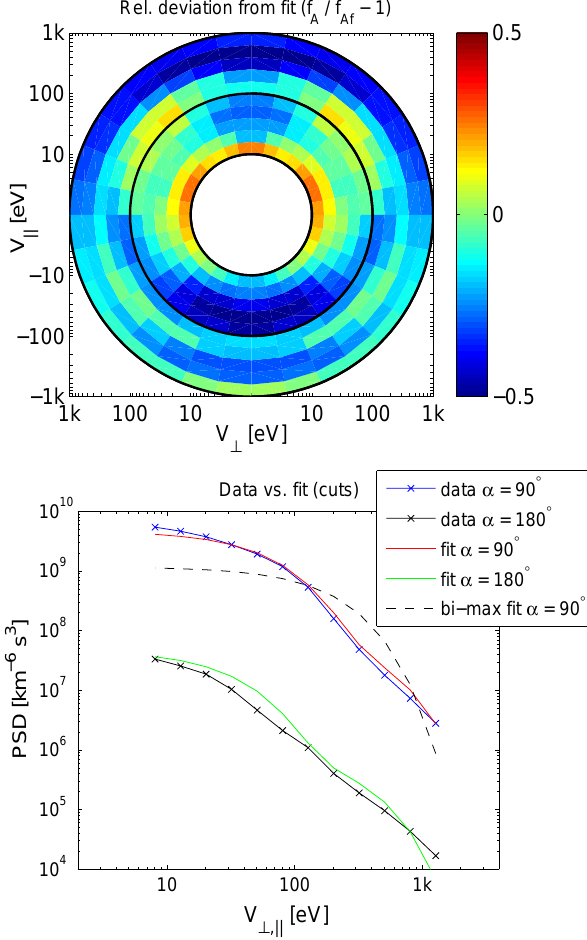
Fig. 3. Fits of the average distribution f A by a double bi- maxwellian model. Top: relative error of the best fit (f A − f Af )/f Af for all pitch angle-energy bins (linear color scale). Bottom: cuts of the average 2-D distribution f A and its double bi-maxwellian fit f Af for pitch angles α close to 90 ◦ and 180 ◦ . For clarity, the paral- lel cuts are rescaled by a factor of 100. Dashed line shows the best bi-maxwellian fit (perpendicular